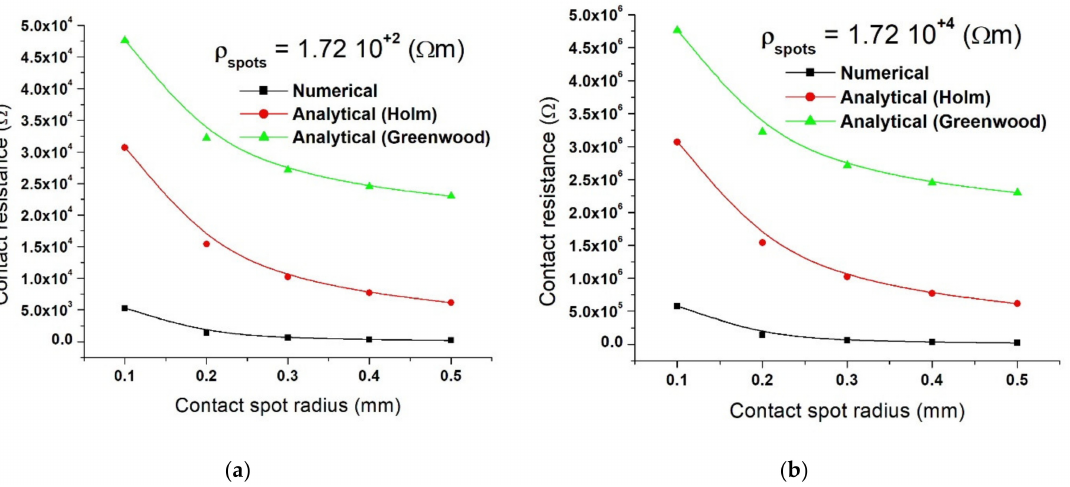
Figure 13. Contact resistance showing values for Holm and Greenwood models and numerical analysis calculated for ρ Cu = 1.72 · 10 − 8 Ω · m, ρ Cs = 1.72 · 10 +2 Ω · m ( a ), and ρ Cs = 1.72 · 10 +4 Ω · m ( b ).